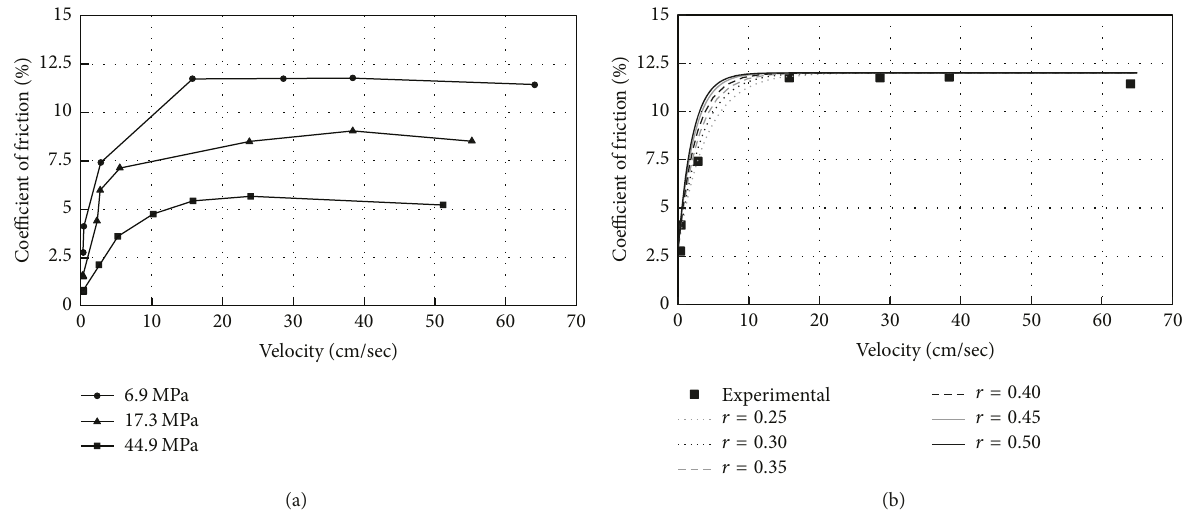
Figure 9: Dependency of the coefficient of friction on sliding velocity: (a) experimental data for different axial stress levels (Mokha et al. 1990); (b) effect of the rate parameter 𝑟